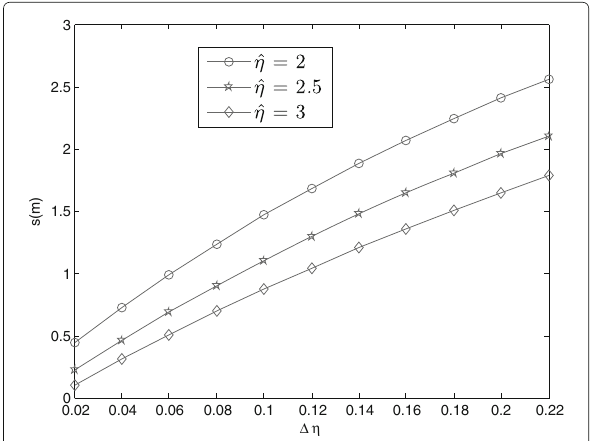
Fig. 10 Relationship between s and (cid:6)η